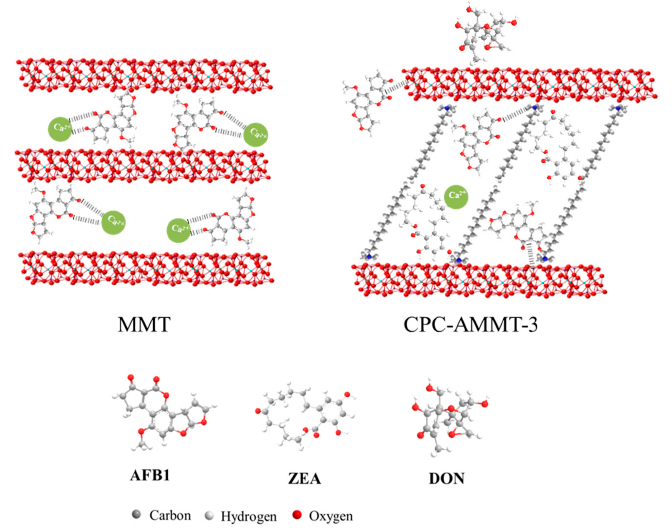
Figure 5 . Schematic mechanism of AFB1, ZEA and DON adsorption on MMT and CPC-AMMT-3. Figure 5. Schematic mechanism of AFB1, ZEA and DON adsorption on MMT and CPC-AMMT-3.